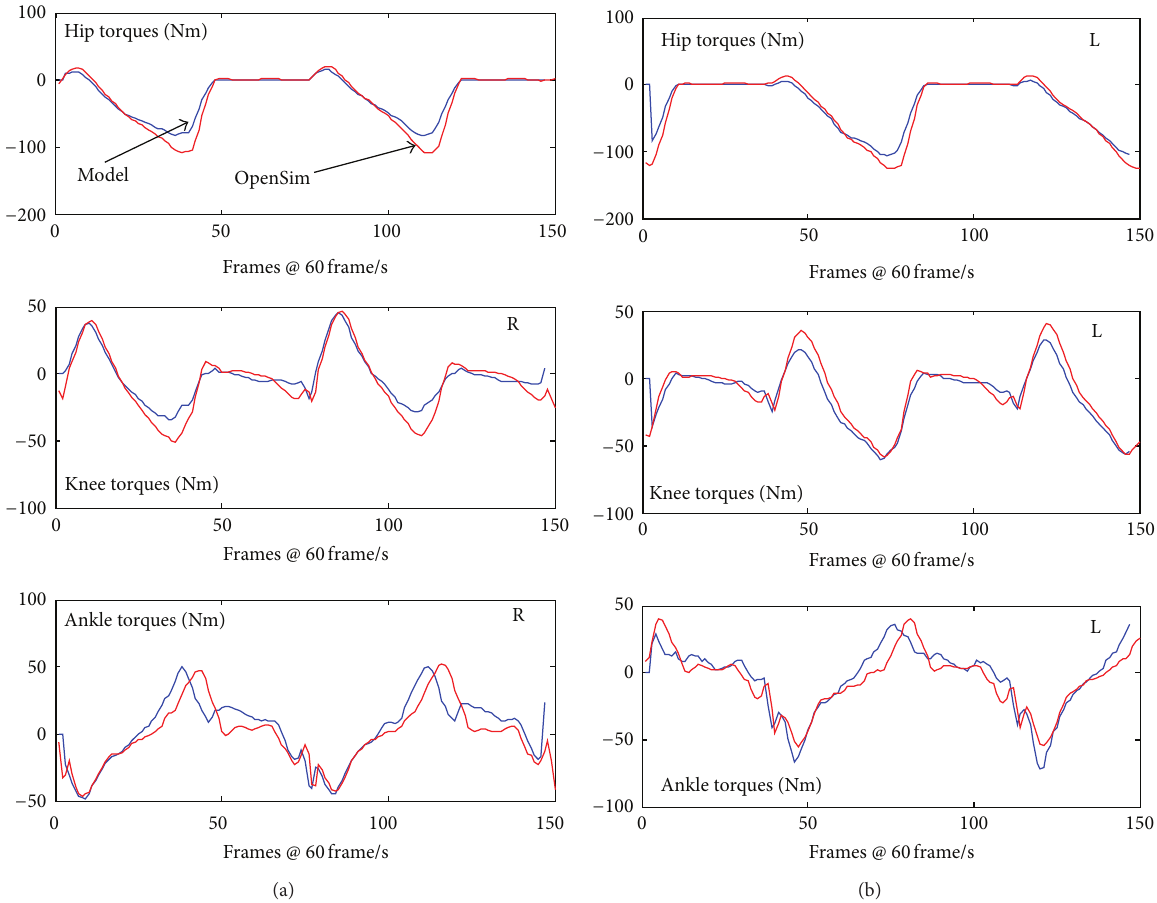
Figure 10: Joint torques output of the developed model (blue) and OpenSim outputs (red): (a) for right limb, and (b) for left limb.